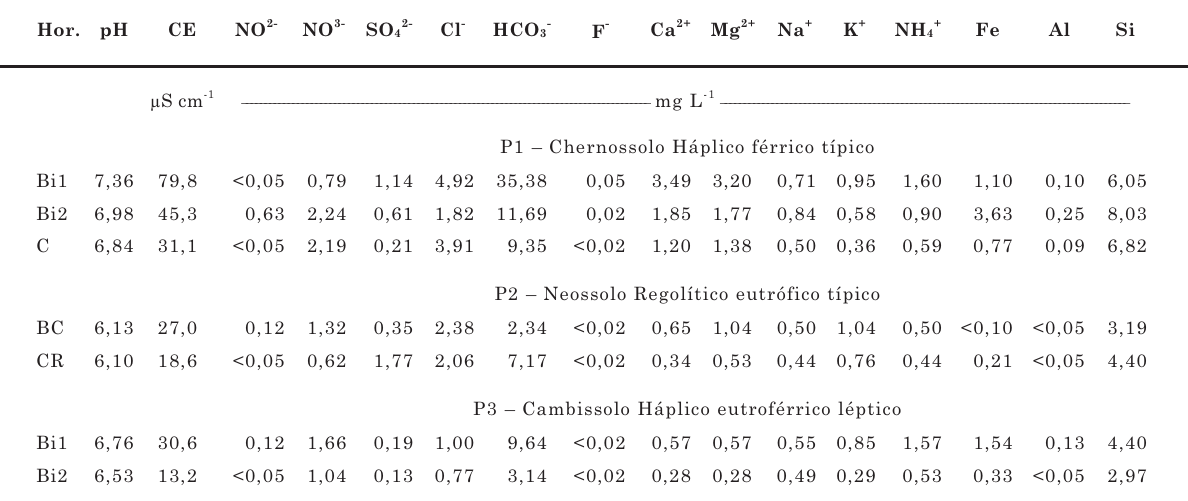
mineral de acordo com os índices de saturação nos extratos de materiais de horizontes